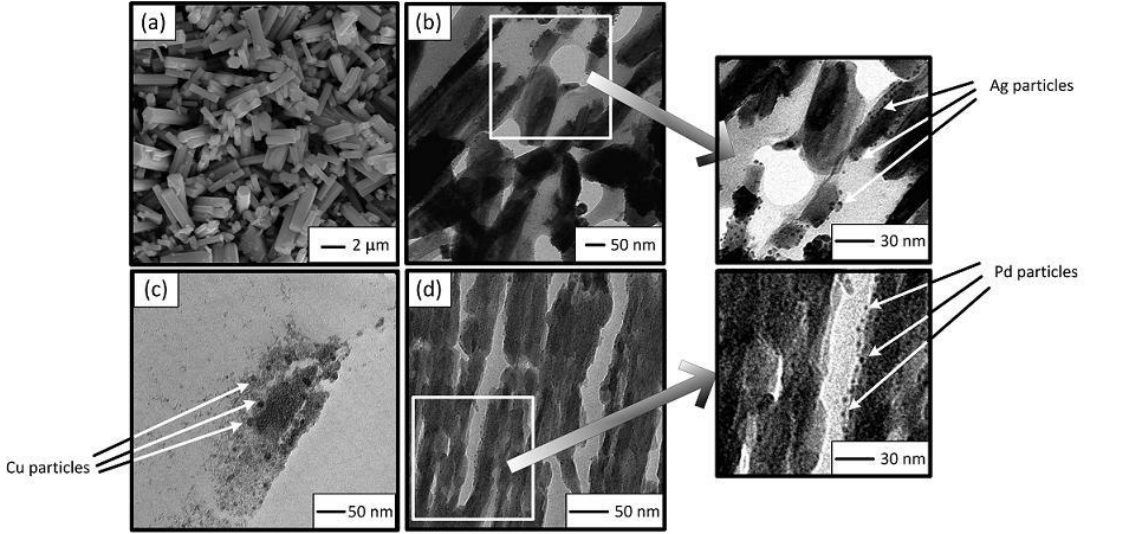
crystallites. TEM images of MoO lamellae with (b) Ag particles, (c) Pd particles, (d) Cu particles. The Figure 1: (a) SEM image of h -MoO 3 3 insertions show the regions of metal-modified lamellae at the enhanced